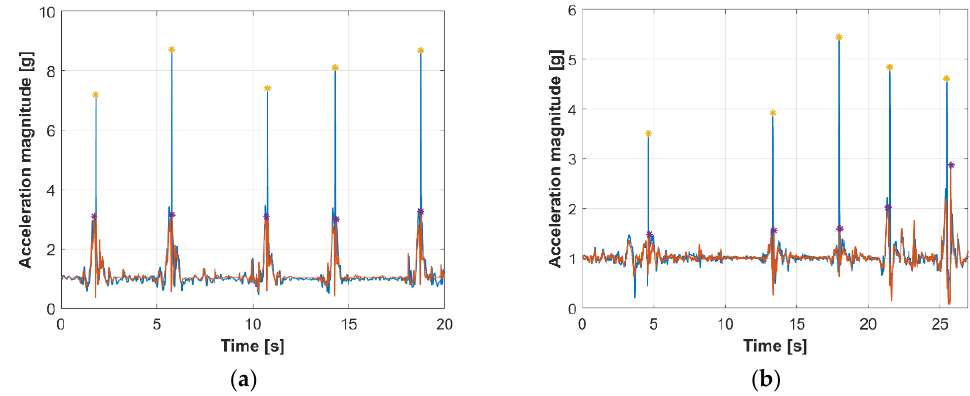
Figure 9. ( a ) Raw signal data extracted from the headband inertial sensor (blue) and T3 inertial sensor (orange) for a semi-professional participant; ( b ) raw signal data extracted from the headband inertial sensor (blue) and T3 inertial sensor (orange) for a novice participant. Head impacts are denoted by a yellow star and T3 impacts are denoted by a purple star.